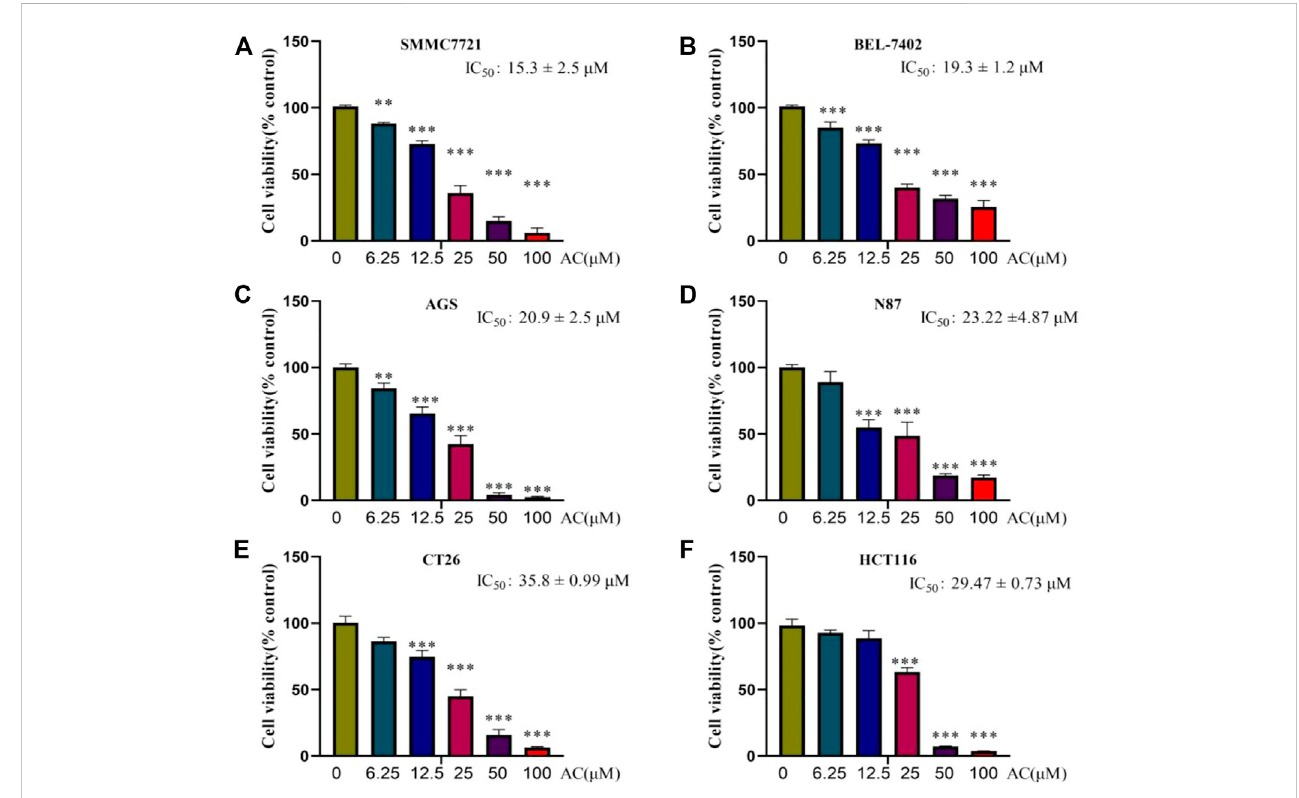
Cytotoxicity of AC on GI tumours. (A , B) The cell viability of SMMC7721 and BEL-7402 were inhibited by AC. (C , D) The cell viability of AGS and N87 were inhibited by AC. (E , F) The cell viability of CT26 and HCT116 were inhibited by AC. * p < 0.05, ** p < 0.01, *** p < 0.001 (vs. 0